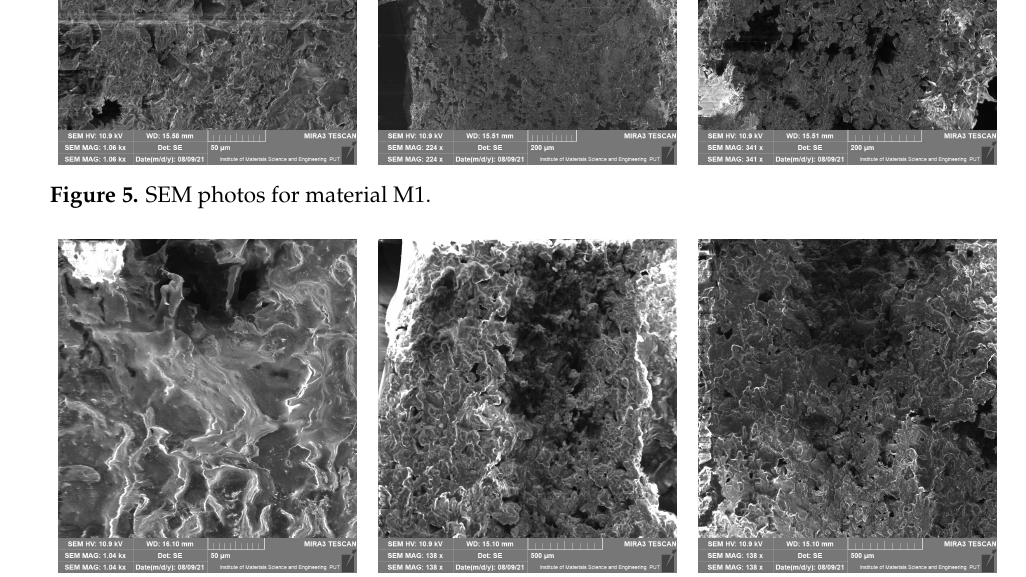
Figure 6. SEM photos for material